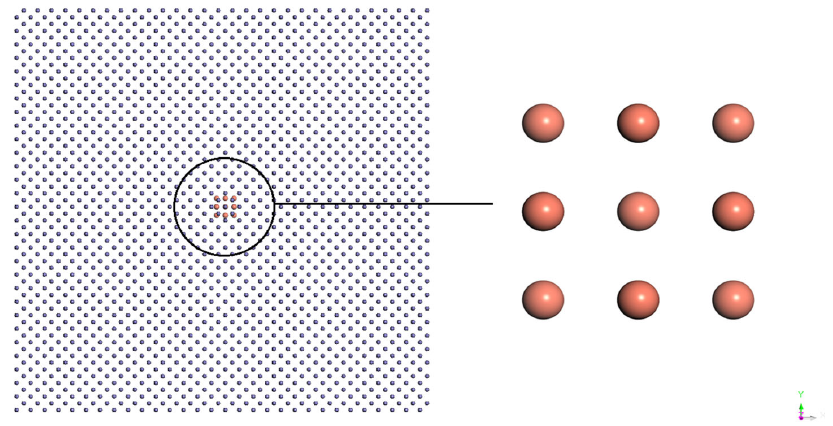
Figure 1. Three-dimensional projection of the Fe bulk –Cu 13 binary Figure 1. Three ‐ dimensional projection of the Fe bulk –Cu 13 binary system.